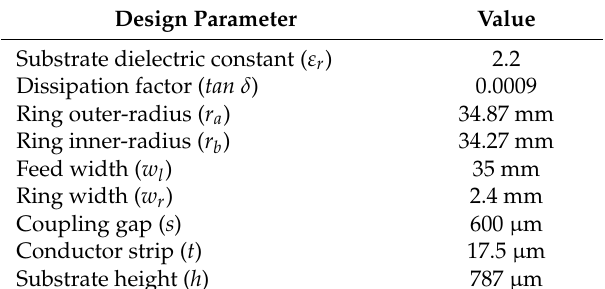
Table 1. Design parameters of a highly sensitive microwave ring-resonator sensor.